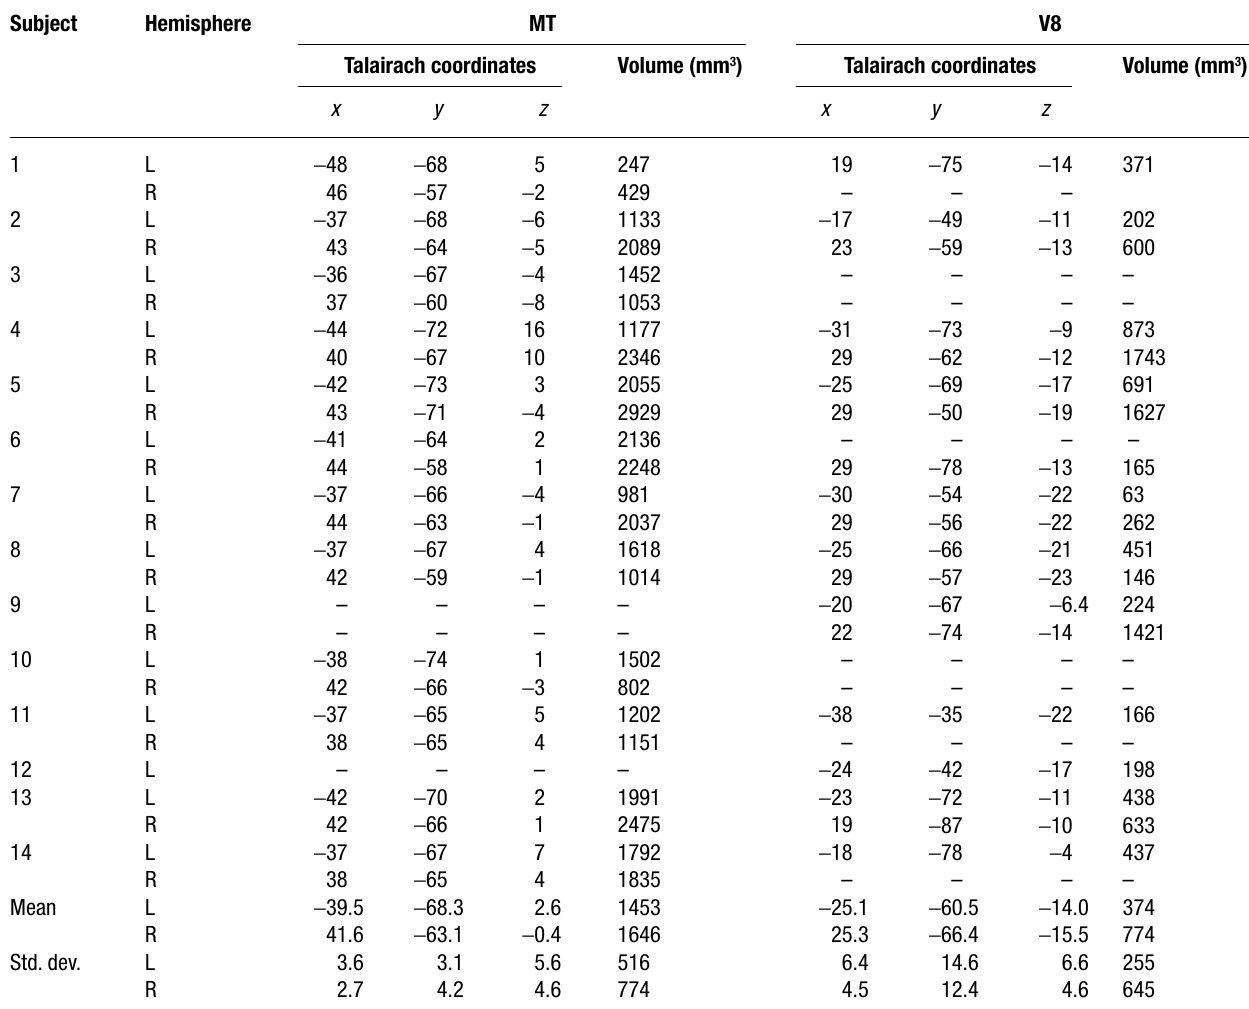
Table 2. Individually defi ned MT and V8 regions of interest, including the hemisphere of the ROI (L = left and R = right), its Talairach coordi- nates (maximum), and volume in mm 3